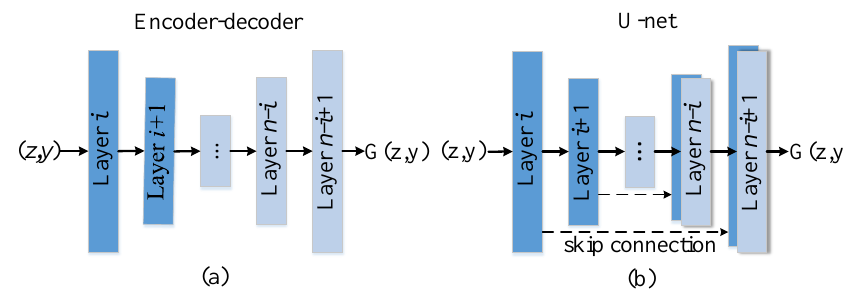
Figure 3. The structures of two generators. ( a ) Encoder-decoder. ( b ) U-net.